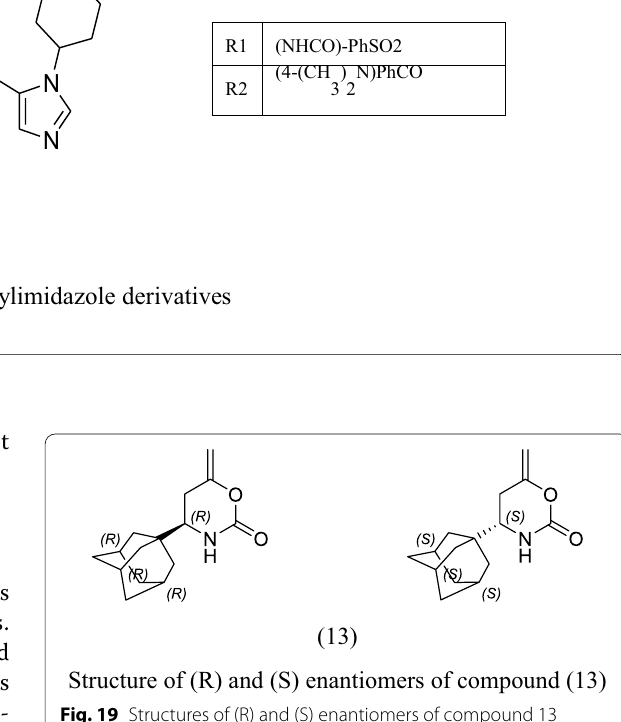
Structure of (R) and (S) enantiomers of compound (13) Fig. 19 Structures of (R) and (S) enantiomers of compound 13